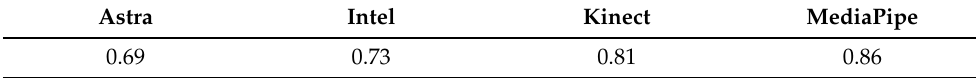
Table 5. Pearson correlation for the angular variation data. For all sensors, p < 0.001. Astra Intel Kinect